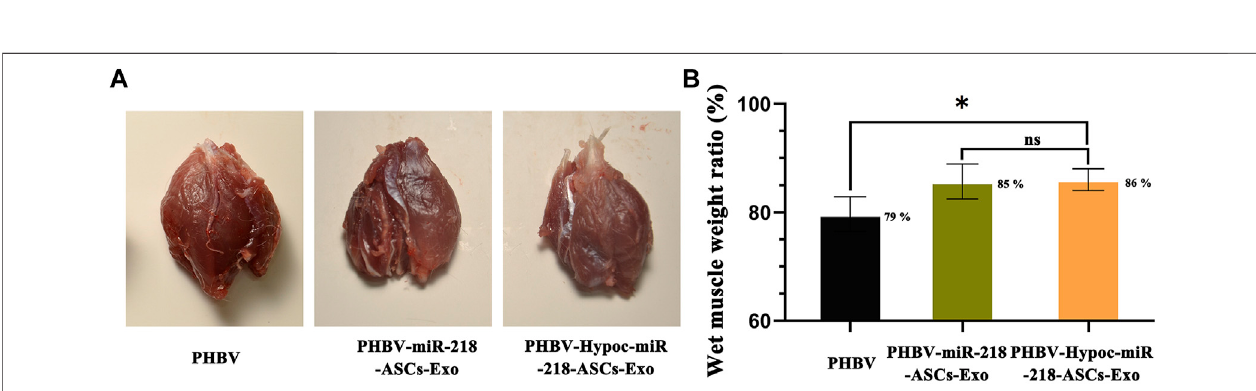
FIGURE 12 | Wet weight of gastrocnemius muscles was tested after animal surgical procedures. (A) Images of gastrocnemius muscles of three groups. (B) Atrophy of gastrocnemius muscle was calculated by wet weight of injured limb and Control group in three groups.